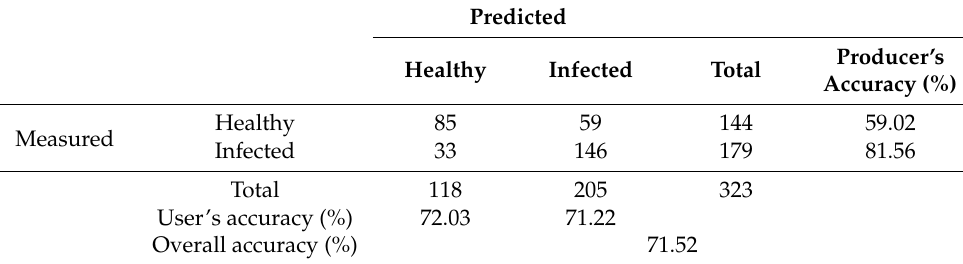
Table 6. Results of Method-SSA on 25 August 2020.